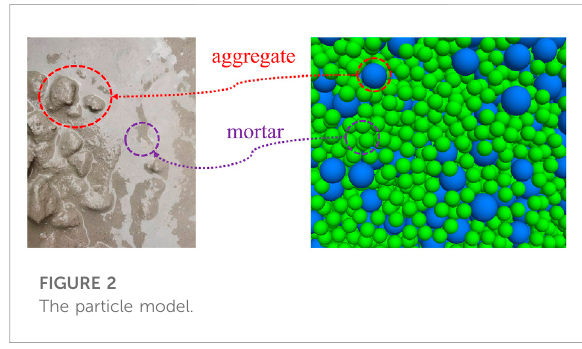
FIGURE 2 The particle model.